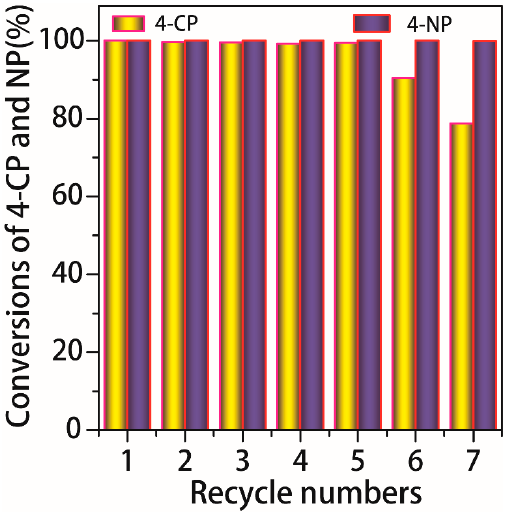
Figure 6. Recyclability of Pd/alk-Ti 3 C 2 X 2 for the HDC of 4-CP and the hydrogenation of 4-NP at 25 °C.